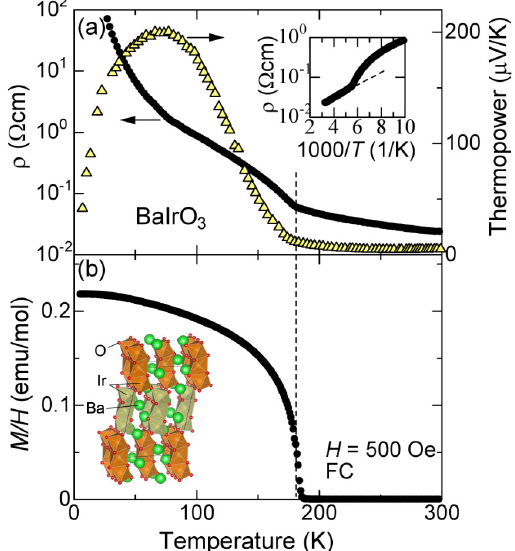
Figure 1. ( a ) resistivity and thermopower of a polycrystalline sample of BaIrO 3 . The inset shows the Arrhenius plot of the resistivity, in which the dotted line indicates the activation transport above the transition temperature T c ; ( b ) magnetization M divided by an external field H of 500 Oe of the same sample. The dotted line represents T c = 182 K. The inset shows the schematic picture of the crystal structure of BaIrO 3